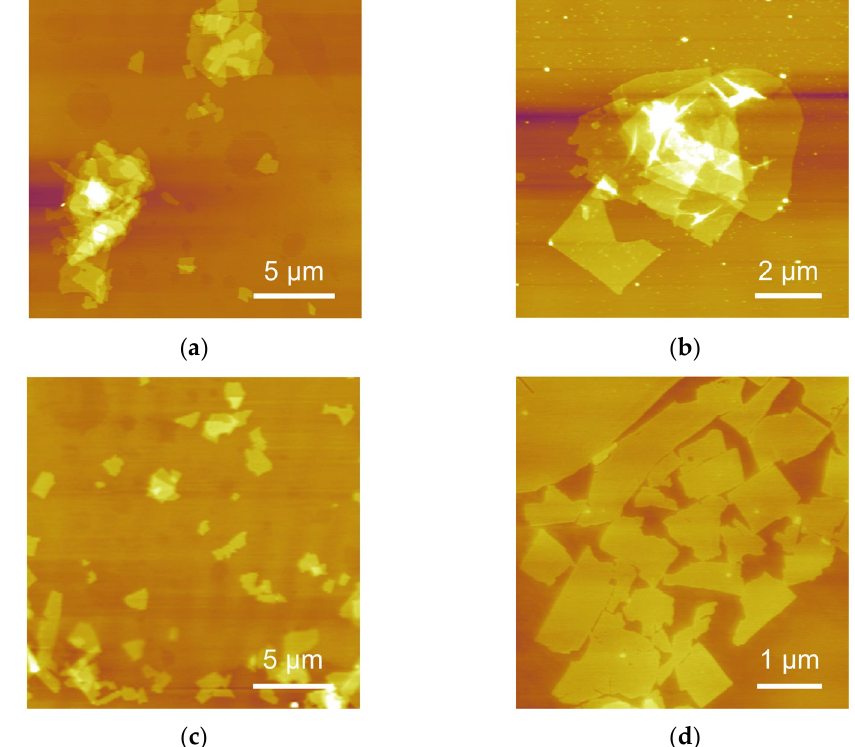
Figure 4. AFM characterization of CNO nanosheets transferred from ( a , b ) CNO/SA and ( c , d ) CNO/SA/PEI dispersion (the weight ratio of PEI to SA is 0.045).